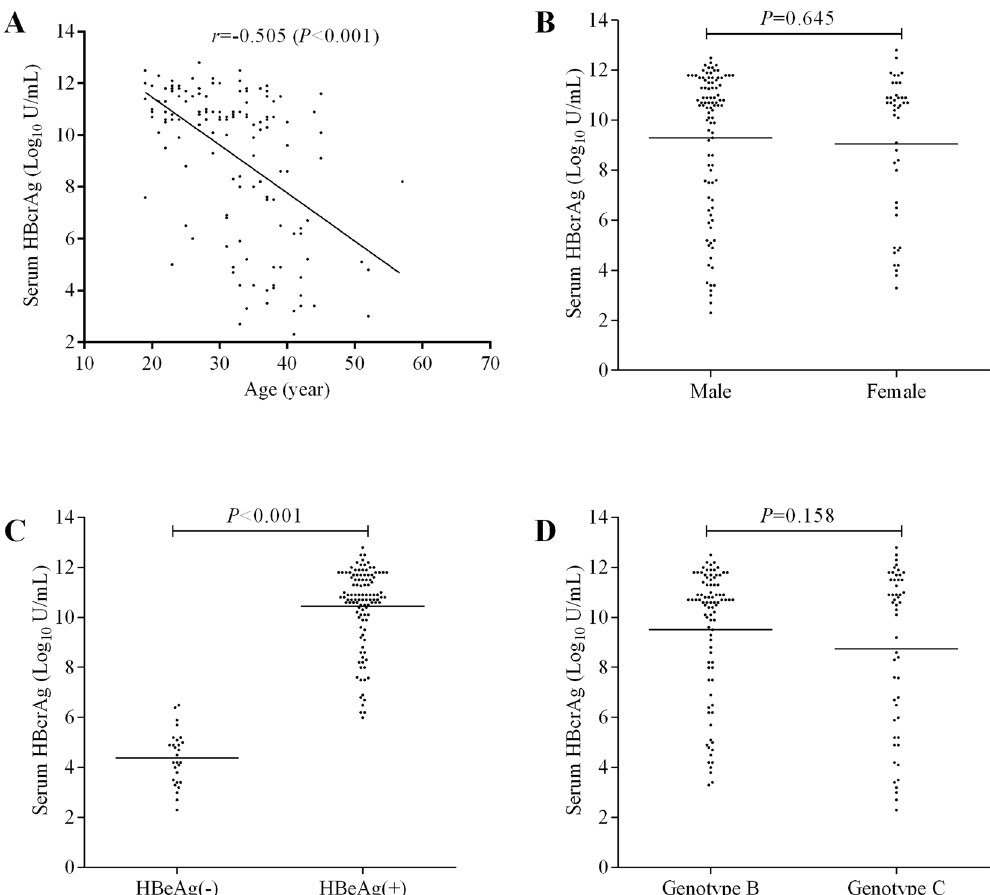
Figure 2. The correlation of serum qHBcrAg with age ( A ), and distribution of serum qHBcrAg distinguished by gender ( B ), HBeAg statue ( C ) and HBV genotype ( D